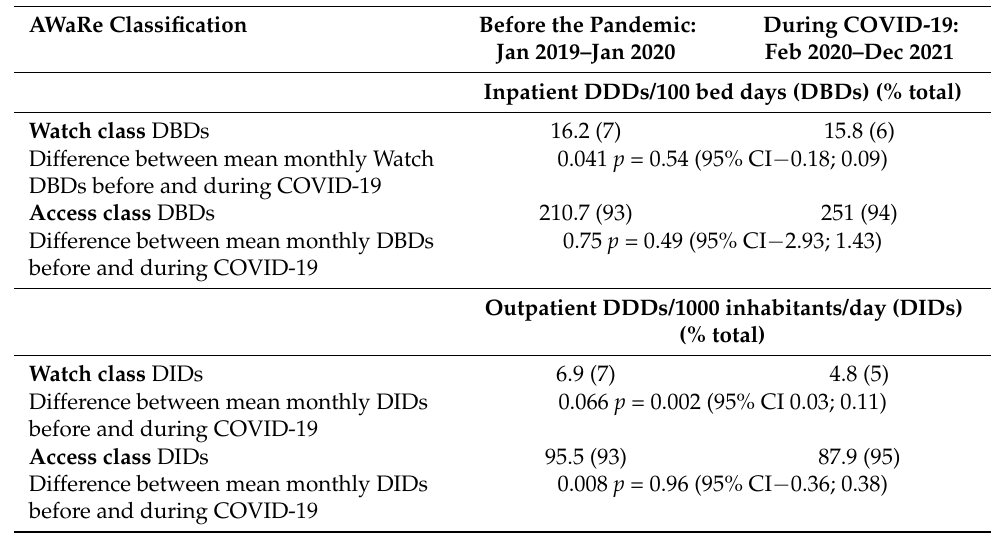
Table 4. Antibiotic consumption by AWaRe classification for inpatients and outpatients at VCH, Vanuatu before and during COVID-19: January 2018 to January 2020 and February 2020 to December 2021, respectively, with percentage of total consumption according to AWaRe classification.